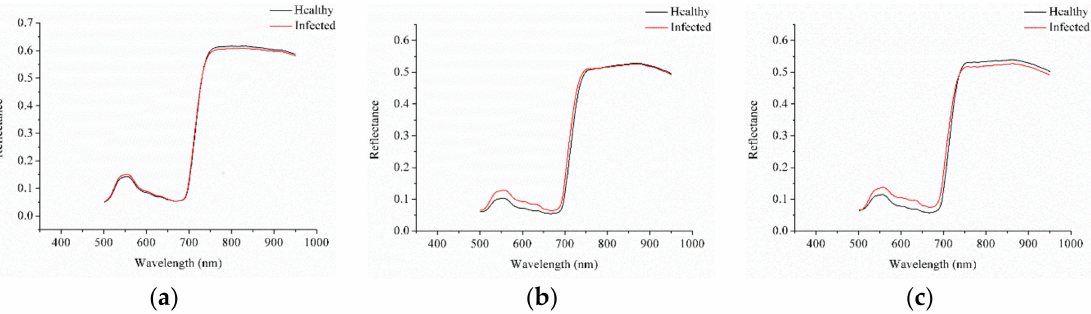
Figure 1. The average spectra of healthy and infected leaves of sample sets 1 ( a ), 2 ( b ) and 3 ( c ).